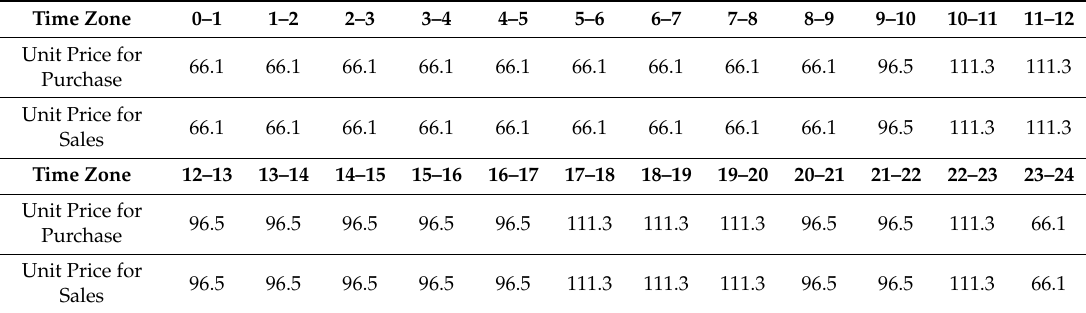
Table 6. Power unit price schedule (virtual data) (Korean won / kWh).